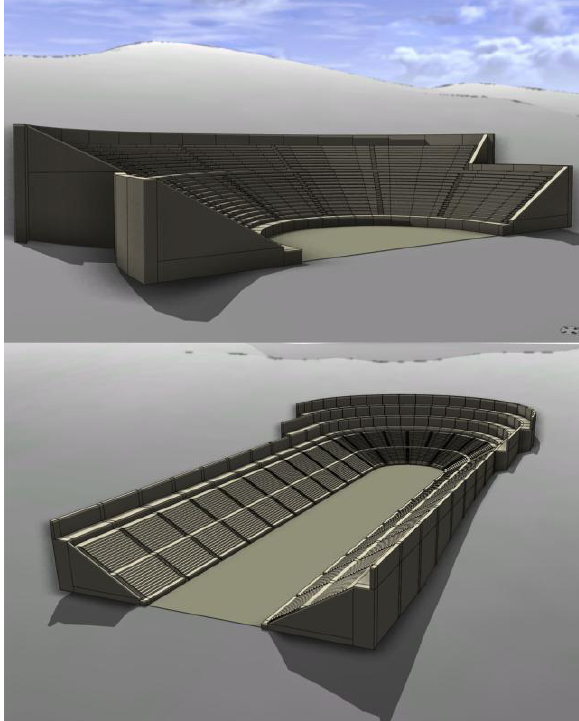
Figure 8: Theatron and Stadium at Magnesia, generated from one generic procedural